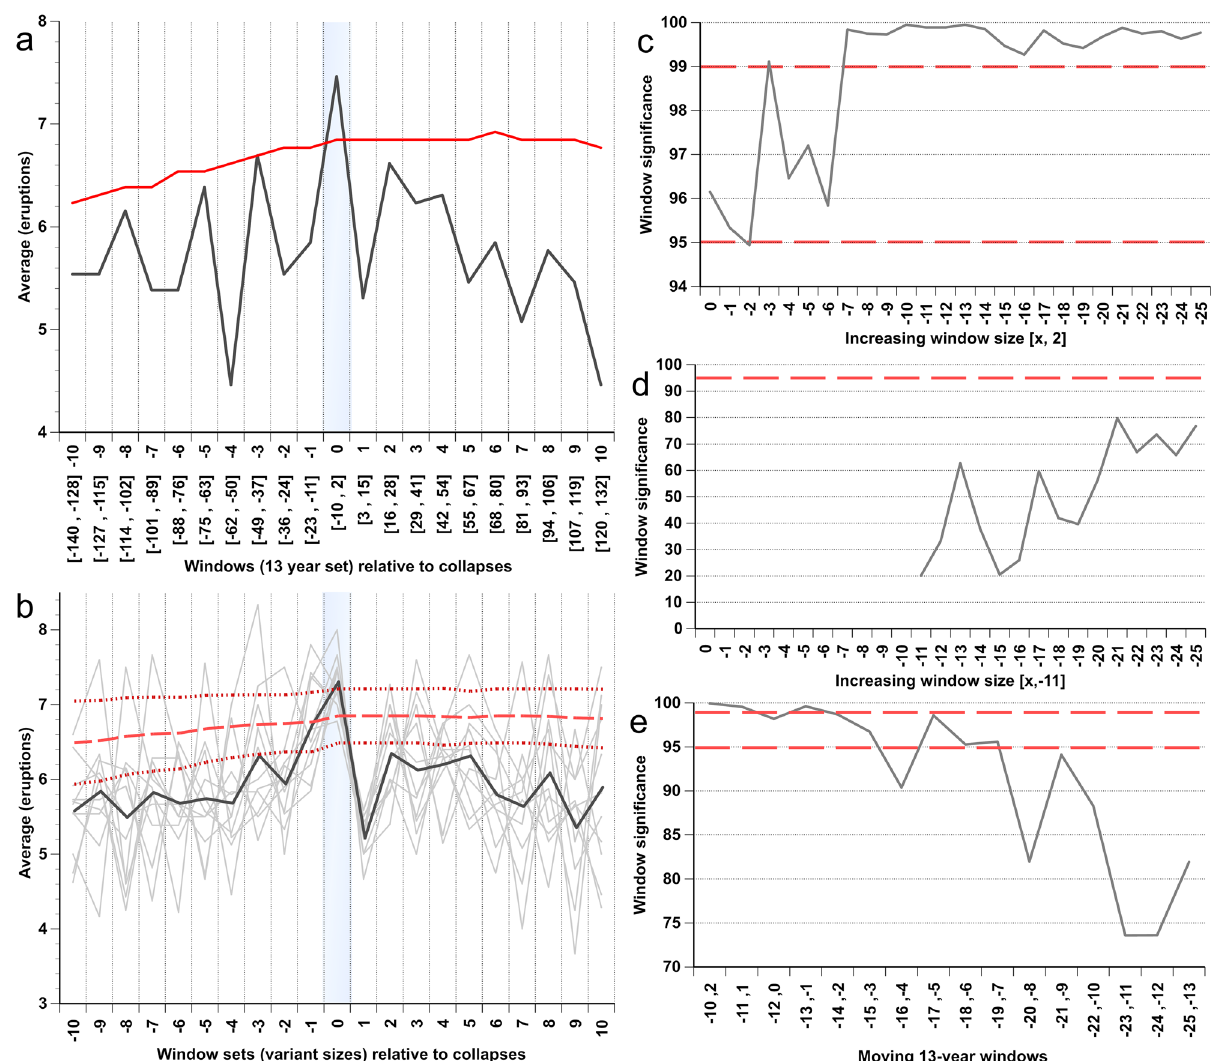
Fig. 2 Incidence of volcanic eruptions relative to Chinese dynastic collapse. a Windowed superposed epoch analysis (SEA) showing the average number of eruptions occurring in 13-year windows relative to our 68 collapse dates (Supplementary Table 1; Methods). The position of the black line at Point 0 on the horizontal axis represents the average number of eruptions occurring within our central [ − 10, 2] year window, i.e., spanning 13 years from the 10 th year preceding our collapse dates, out to the 2 nd year following, inclusive. The black line at Point − 1 thus represents the average number of eruptions falling within the 13-year window that fi rst precedes this (i.e., encompassing the 23 rd to 11 th years preceding collapse), whereas the black line at Point 1 thus represents the average number of eruptions falling within the 13-year window that fi rst follows this (i.e., encompassing the 3 rd to 15 th years following collapse), and so on. The 99% Monte Carlo (upper bound) signi fi cance threshold is indicated by the red line. b Summary of multiple SEAs using variant (increasingly smaller) window lengths (Supplementary Data 2; Methods). The thick black line shows the “ composited ” average (i.e., mean average) number of eruptions occurring relative to our 68 collapse dates, from all tested variant window lengths combined. The thin gray lines show the average number of eruptions for each tested window length, individually. These range from the 13-year window length shown in a , at the largest, down to a 3-year length, at the smallest. The central window ([0, 2]) for this smallest variant window length thus falls at Point 0 on the horizontal axis and encompasses the years of collapse (i.e., year 0) out to the 2 nd years following, inclusive. Point − 1 for this window variant thus encompasses the 3 rd to the 1 st years [ − 3, − 1] before the collapse, and Point 1 the 3 rd to the 5 th years following, and so on. The red dashed line shows the average of all individual 95% signi fi cance thresholds for each tested window length, whereas the dotted red lines show the ±1 standard deviation around this average. c The Monte Carlo statistical signi fi cance level reached when iteratively increasing the size of the central window by 1 year, from the smallest window of [0, 2] years (i.e., 3-year span) to [ − 25, 2] years (i.e., 28-year span) (Supplementary Table 2). d The same as c but excluding the fi rst 10 years preceding collapse (i.e., the fi rst window tested comprises the 11 th year alone before our collapses, while the fi nal window tested comprises the 11 th to 25 th years before our collapses (i.e., window [ − 11, − 11] with a 1-year span to window [ − 25, − 11] with a 15-year span) (Supplementary Table 3). e Shows the Monte Carlo statistical signi fi cance level reached when maintaining the 13-year default central window length but now moving this window in 1-year increments away from the dates of collapse (i.e., beginning with the [ − 10, 2] year window relative to collapse, and progressing to the [ − 25, − 13] year window) (Supplementary Table